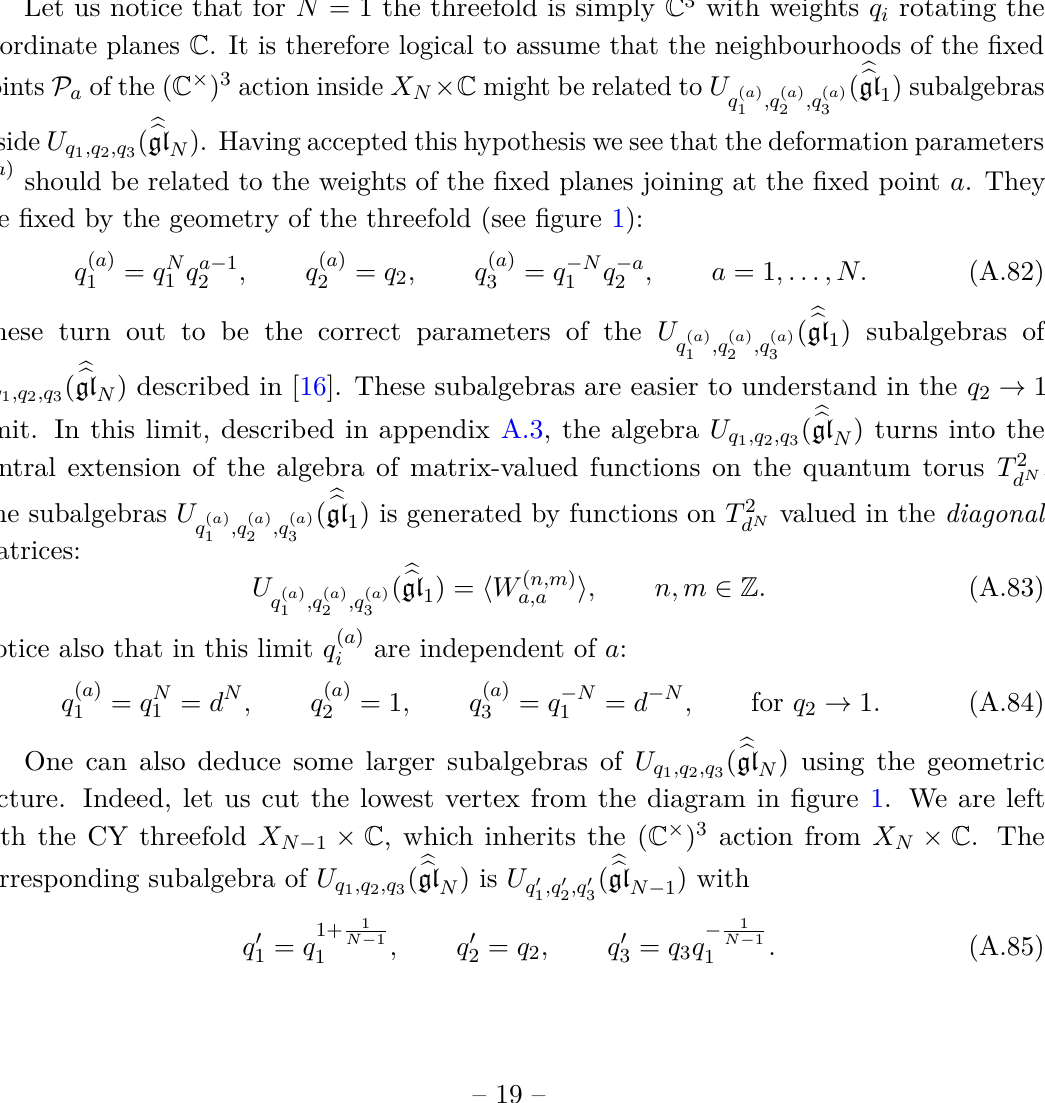
Figure 1 . Toric diagram of the threefold X N × C , where X N = corresponds to a ( C × ) 3 fixed point P a with indices on the legs denoting the weights of the ( C × ) 3 action. These weights, q ( a )